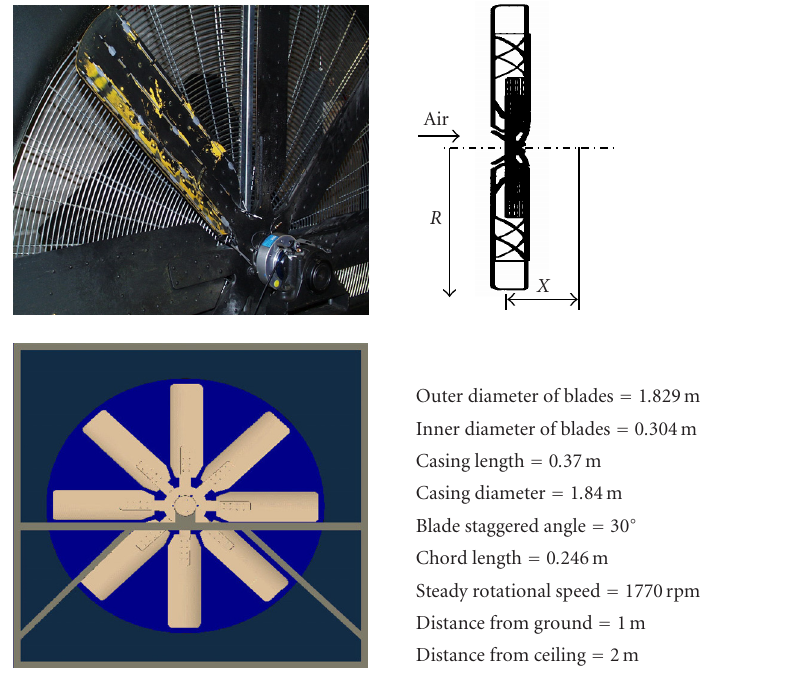
Figure 1: Dimensions of the axial fan and its sideview.